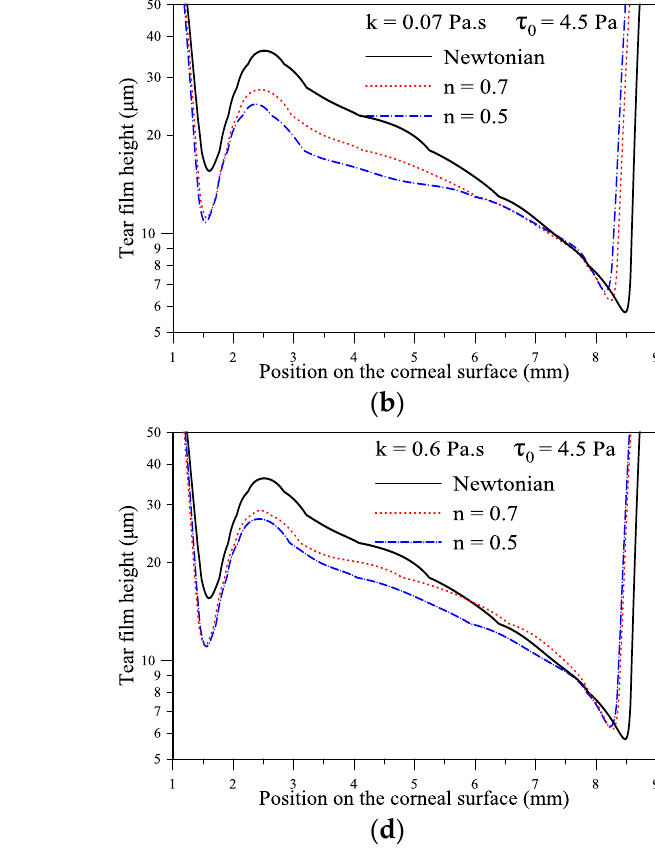
Figure 3. Effect of flow index, n, on variation of film thickness for τ 0 = 1 and 4.5 Pa, k = 0.07 and 0.6 Pa·s at t = 0.18s. ρ = 10 3 kg·m −1 , μ = 1.3 × 10 −3 Pa.s (Newtonian case), σ = 0.045 N/m, h * = 0.0005 m, L cl = 0.001 m, L op = 0.01 m, U 0 = 0.0163 m/s. ( a – d ) indicate the same simulation with different values for the parameters indicated within the figure.